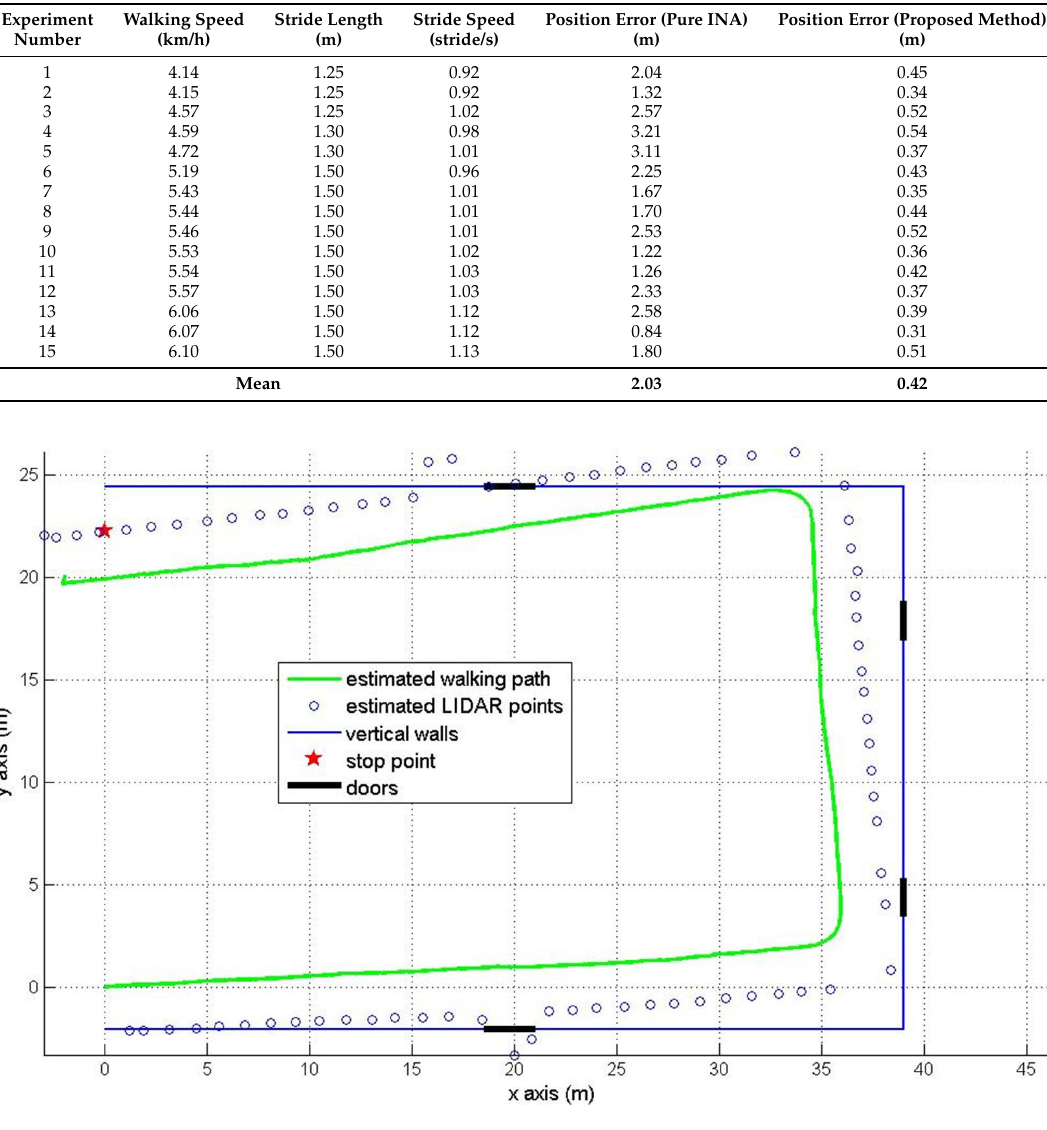
Figure 10. Pedestrian path in the U shaped corridor using a pure